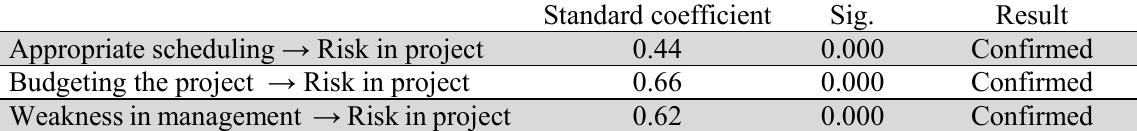
The results of standard